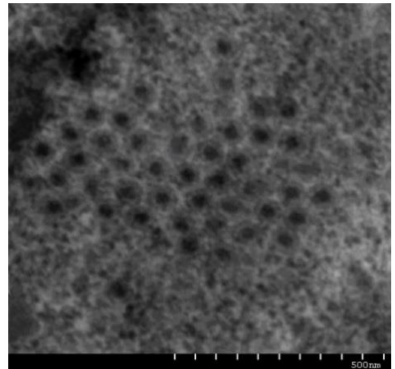
Figure 2. Electron micrograph of HGCRV. GCO cells infected with HGCRV were made into ultrathin slices and observed using transmission electron microscopy. HGCRV, healthy grass carp reovirus; GCO, grass carp ovary.